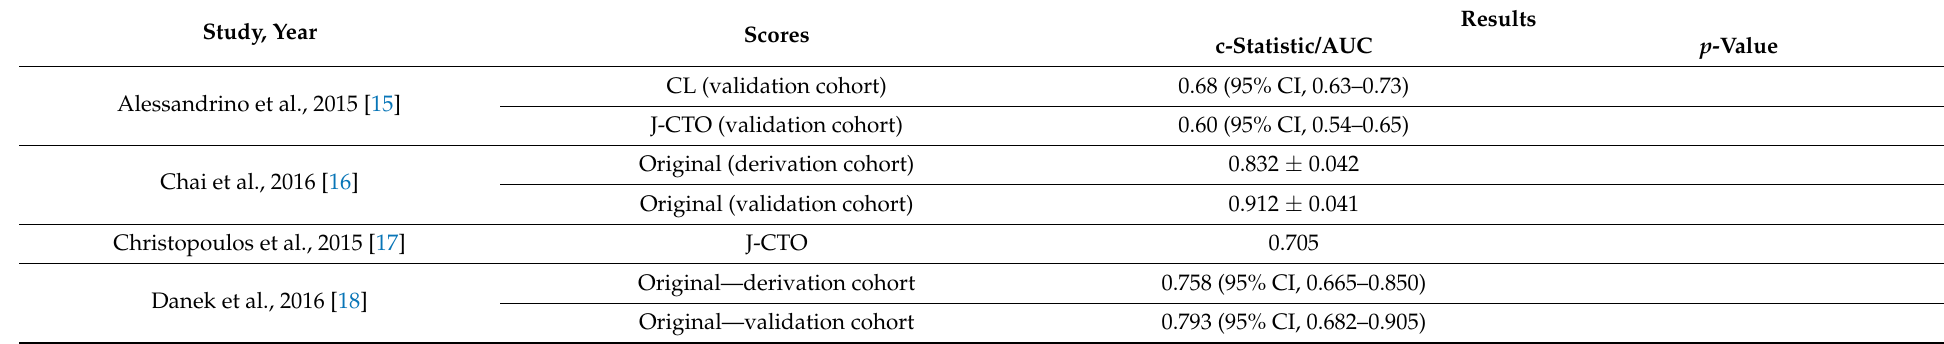
Table 2. Results reported in studies included in the present systematic